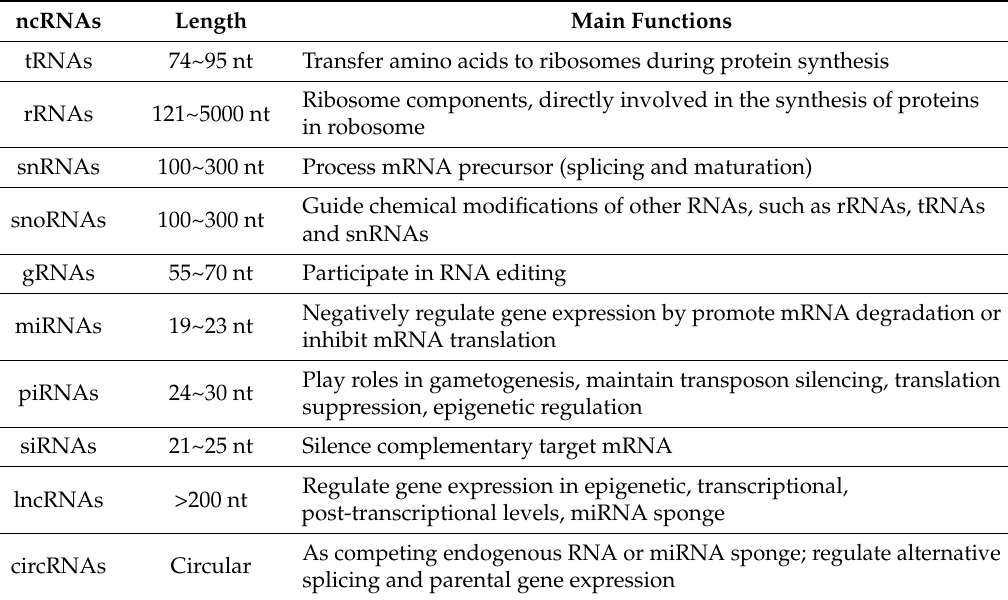
Table 1. The classification and function of non-coding